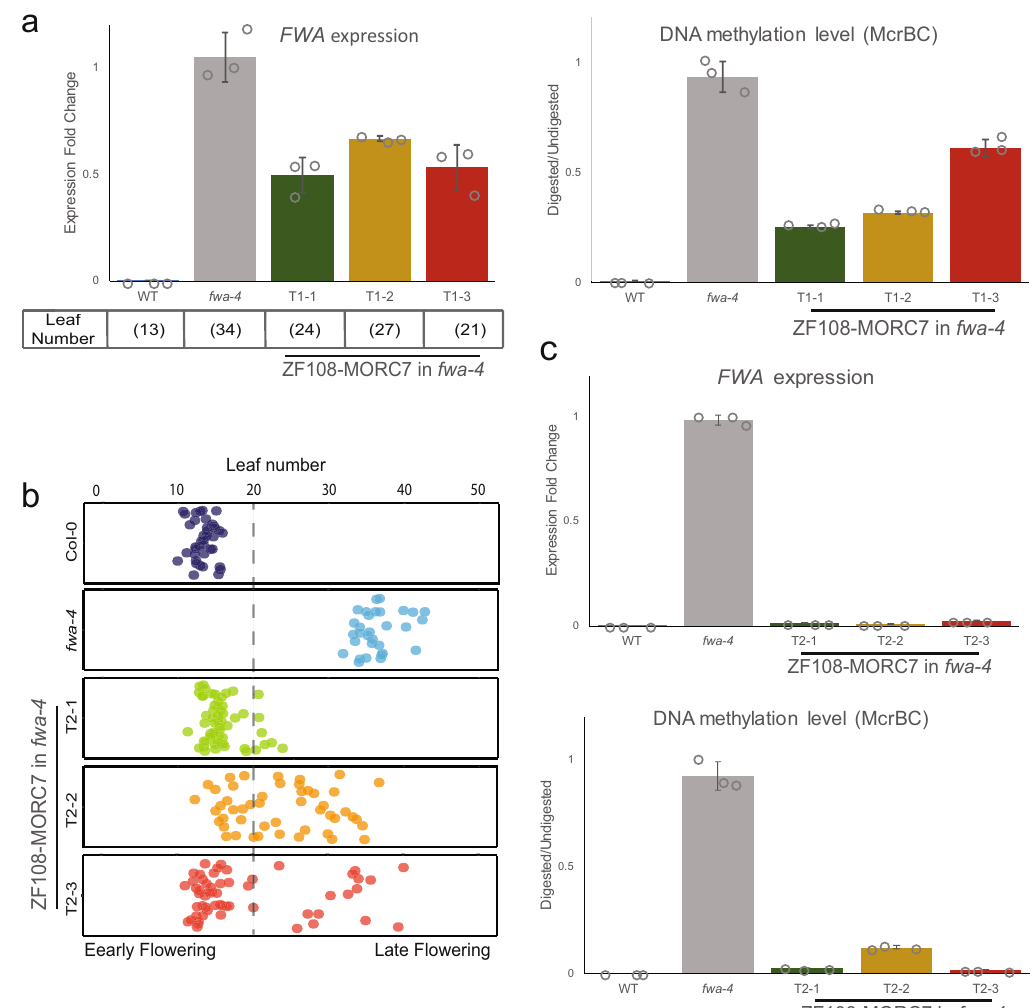
Fig. 5 ZF108-MORC7 silences FWA expression through RdDM. a qRT-PCR analysis showing FWA expression level relative to fwa-4 (left panel) in three independent ZF108-MORC7 T1 plants that displayed early fl owering phenotype. Leaf numbers of these plants are indicated below the bar graph. McrBC analysis with the FWA promoter of the same plants is shown in the right panel. Error bars represent the mean ± s.d. of 3 technical replicates. b Flowering time of Col-0, fwa-4 , and T2 progenies of the three early fl owering T1 plants shown in a . c qRT-PCR of FWA expression level relative to WT (top) and McrBC analysis of the FWA promoter (bottom) of one representative plant in each T2 line displayed in b . Error bars represent the mean ± s.d. of 3 technical replicates. Source data underlying Fig. 5 are provided as a Source Data fi